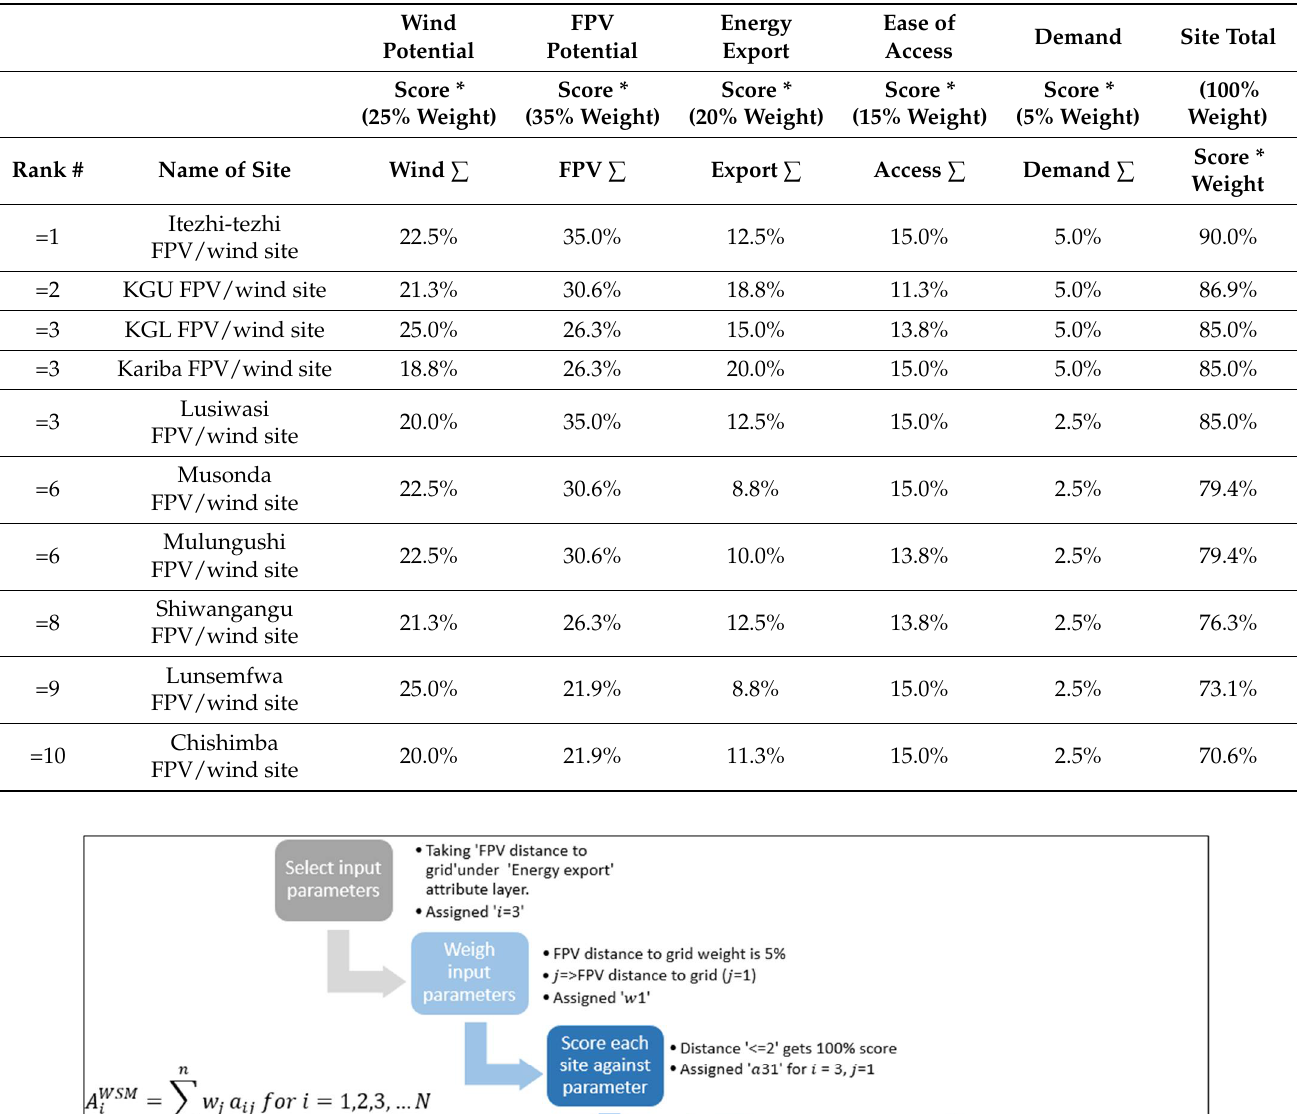
Table 4. Table showing balanced scoring and ranking matrix. Analysis based on sources [70,75–78,94–103] (detailed table shown in Appendix A—Tables A2 and A3).